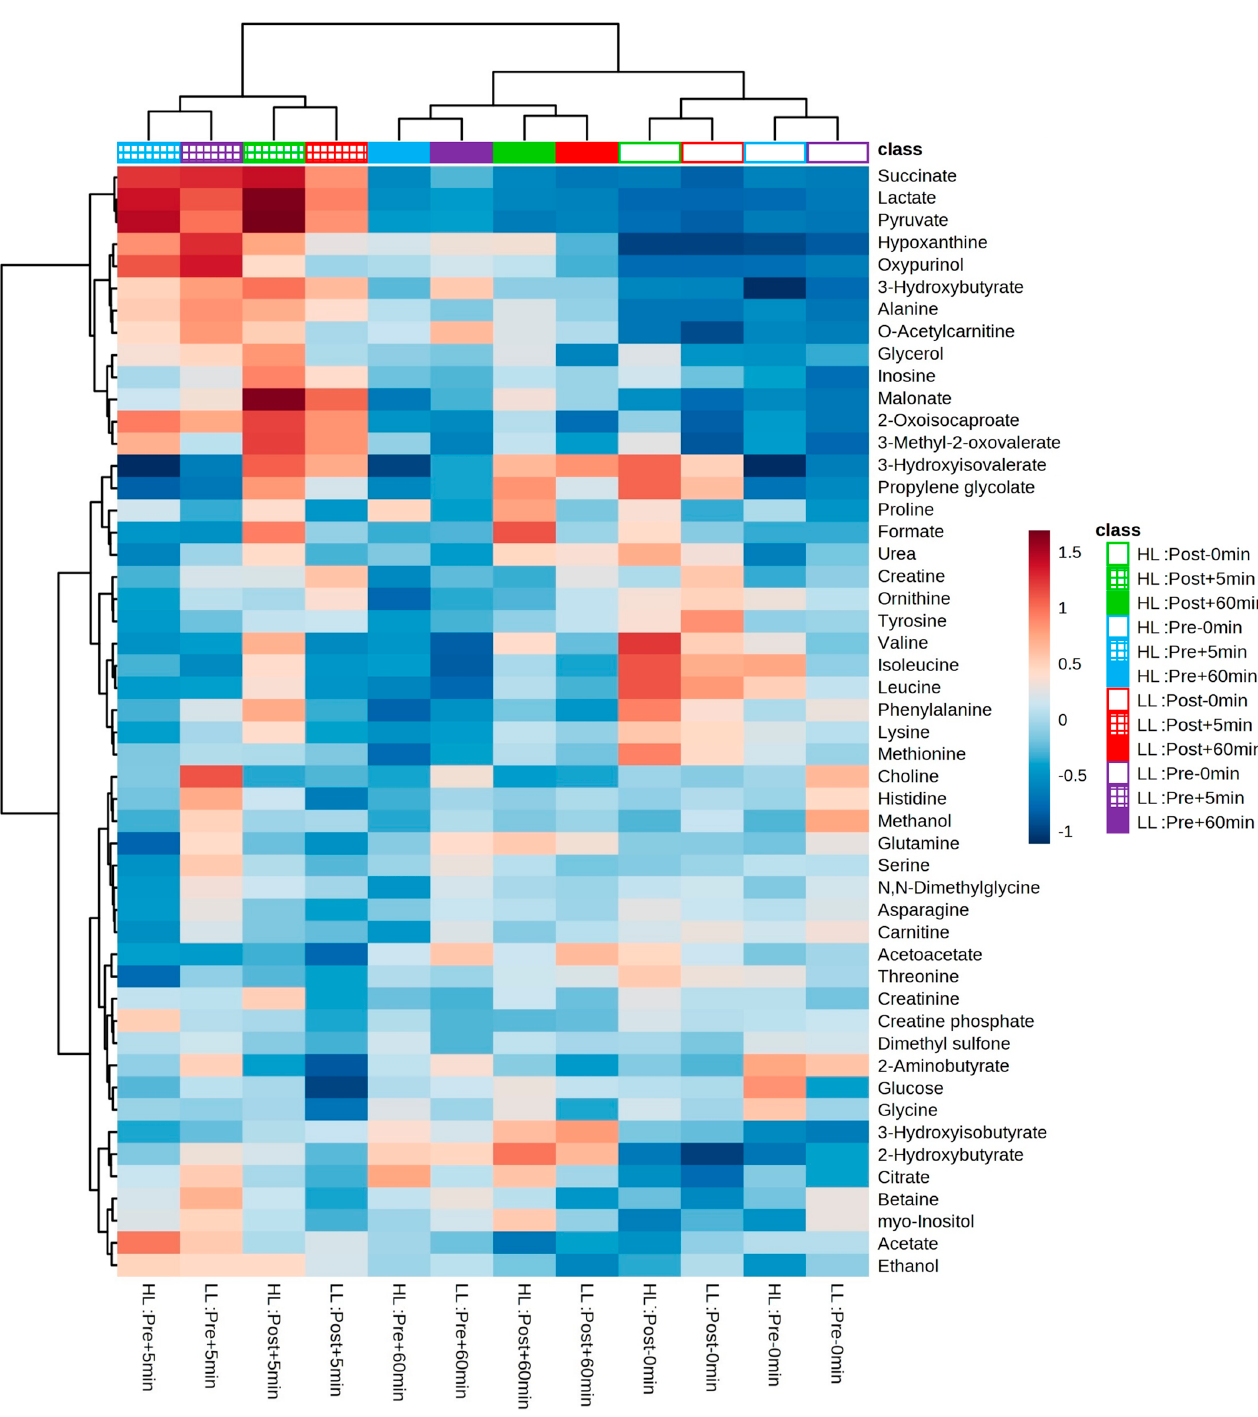
Figure 6. Heatmap and hierarchical clustering analysis (based on the Euclidian distance measure and the Ward clustering algorithm) between and within groups. Cells represent the mean of standardized concentration levels (auto-scaled data). Blue represents lower concentration level, and red represents higher concentration level. HL = high-load resistance training; LL = low-load resistance training; Pre = pre-training period; Post = post-training period; − 0 min = blood collection performed before the exercise (baseline); +5 min = blood collection performed 5 min after exercise; +60 min = blood collection performed 60 min after